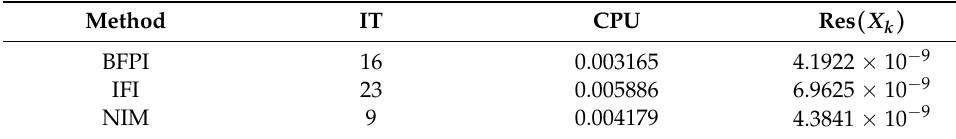
Table 2. The numerical results of Example